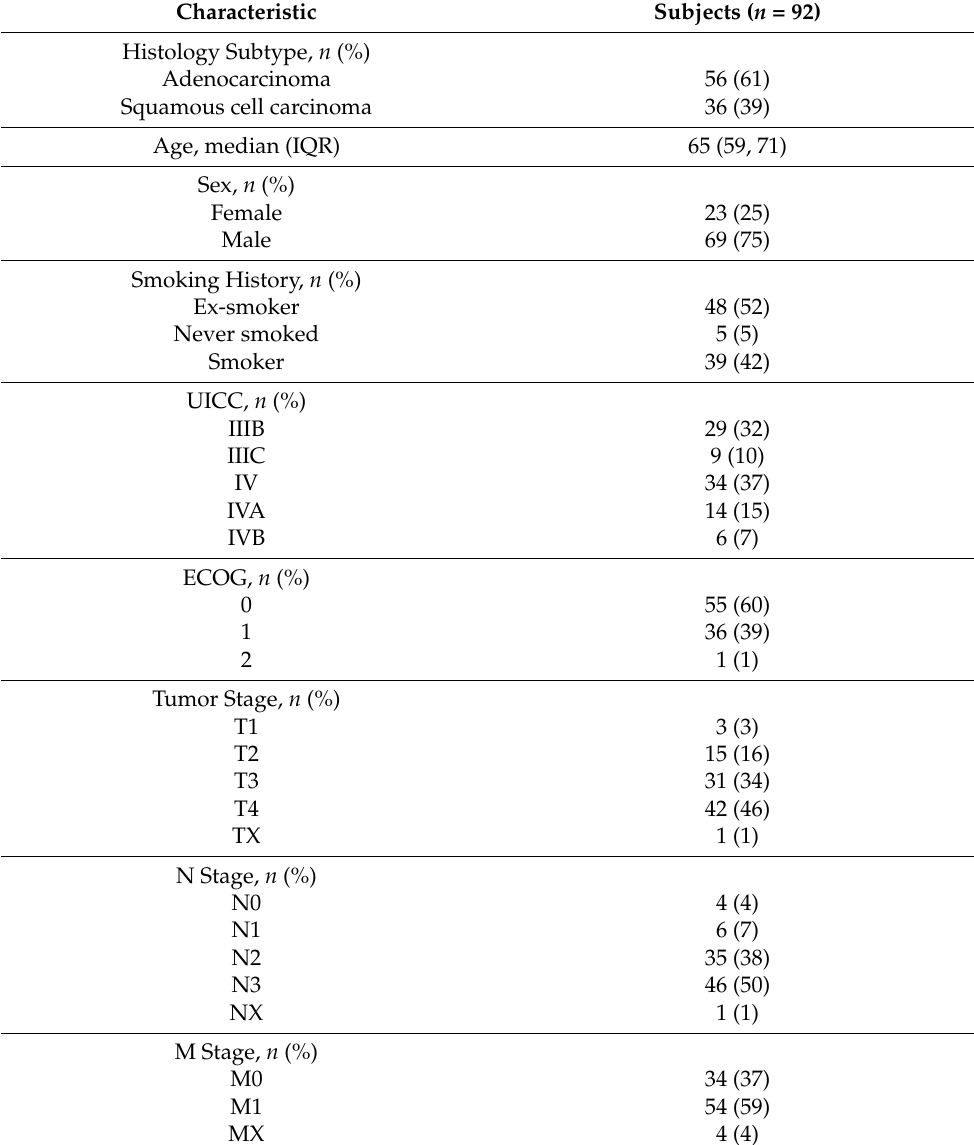
Table 1. Baseline characteristics of study